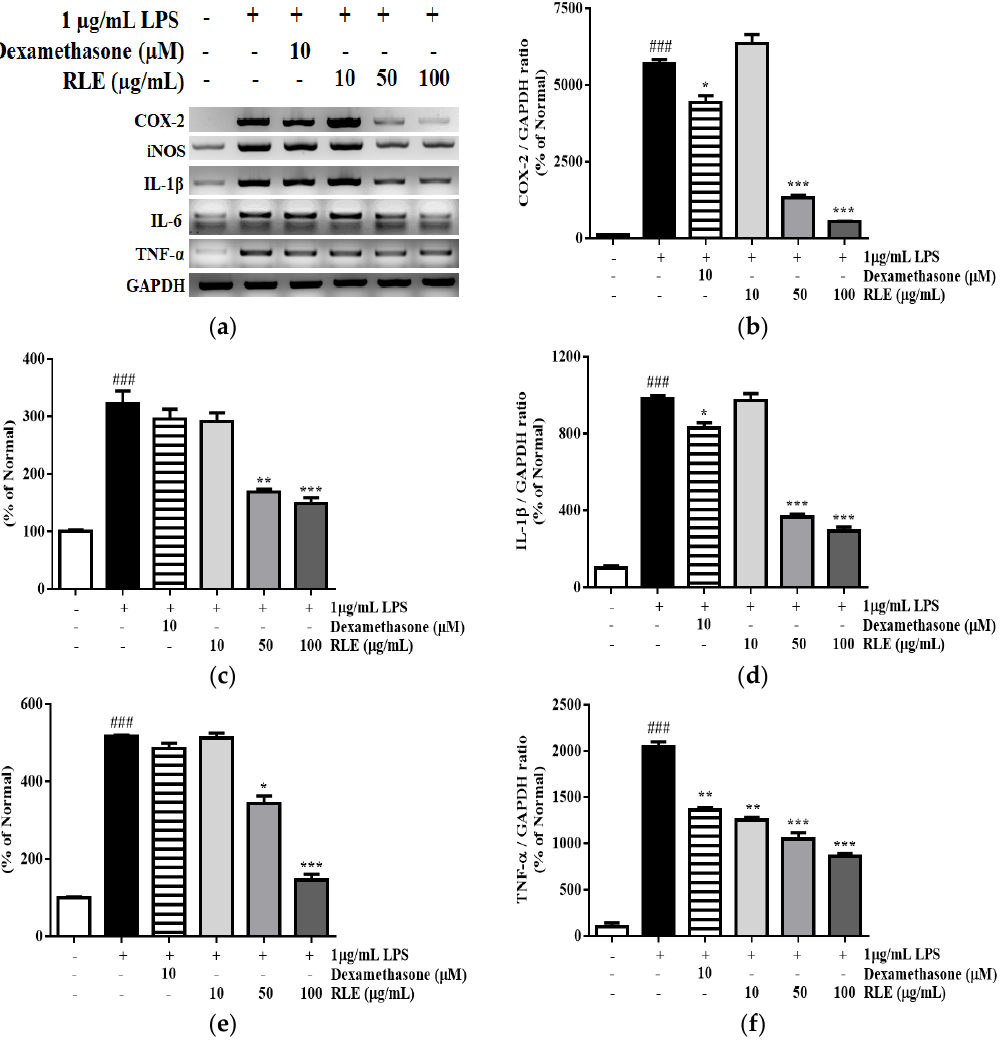
Figure 7. The effects of R. davurica Pall. leaf extract on the mRNA levels in LPS ‐ induced RAW 264.7 cells. The mRNA levels were determined by RT ‐ PCR ( a ). The band intensities were quantified by densitometry, normalized to the level of COX − 2 ( b ), iNOS ( c ), IL − 1 β ( d ), IL − 6 ( e ), and TNF −α ( f ) calculated as the percentage of the non ‐ treated group. Data are presented as the mean ± SD. * indicate significant differences between the non ‐ treated cells and LPS ‐ induced groups, respectively. ### p < 0.001 vs. the non ‐ treated group. *, ** and *** p < 0.05, 0.01, and 0.001 vs. the LPS ‐ induced control, respectively.